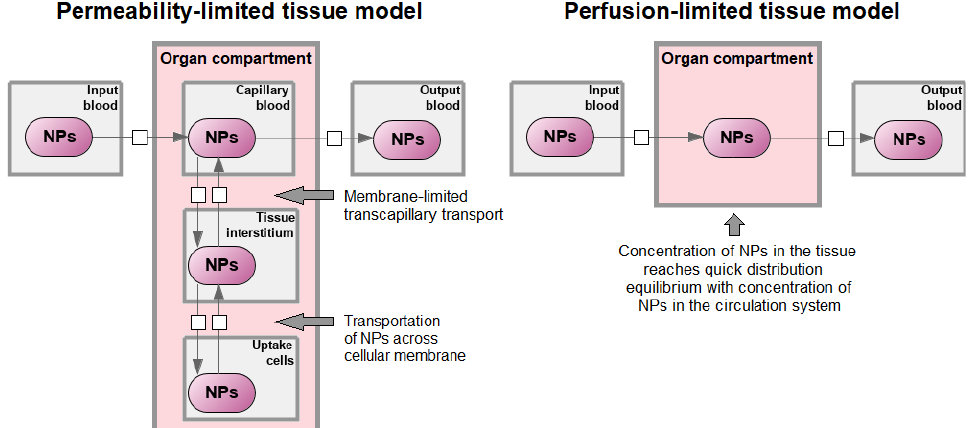
Figure 3. Perfusion-limited and permeability-limited models. The perfusion-limited model assumes that nanoparticles’ (NPs) transportation into tissues is very fast and equilibrium between blood and tissue could be reached instantly. Under such a situation, the transportation of NPs into one tissue depends on its blood supply. In a permeability-limited model, it is assumed that there could be a membrane at the capillary or cellular membrane, or both. Transportation of NPs across cellular membranes is characterized by such mechanisms as endocytic uptake (i.e., phagocytosis, macropinocytosis, and receptor-mediated endocytosis) and exocytic release. Phagocytic cells include reticuloendothelial system cells: monocytes circulating in the blood, Kupffer cells in the liver, reticular cells in the lymph nodes, bone marrow, and spleen, and fixed macrophages of various connective tissues [24,60]. Examples of the perfusion-limited models for NPs can be found in [55,57,60,61]. The permeability-limited models are available in [50,60,61].